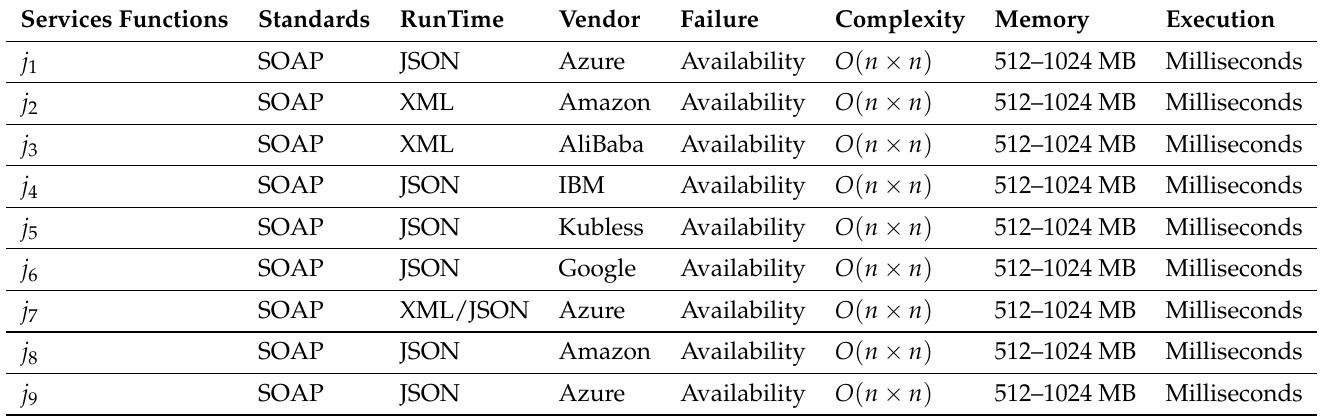
Table 3. Rules and Standard for Functions to be Part of Proposed